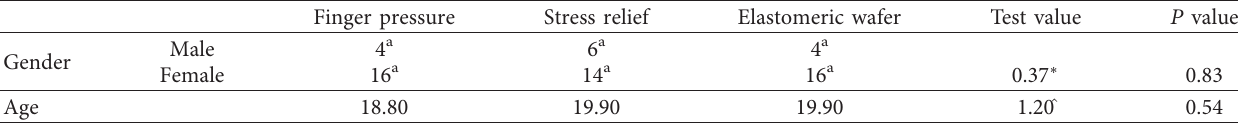
Table 1: Descriptive statistics about patient